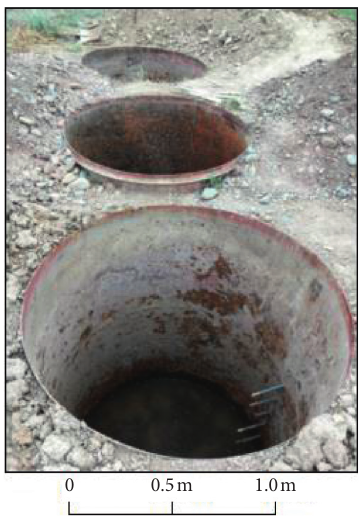
Figure 3: Empty cylindrical test barrels.